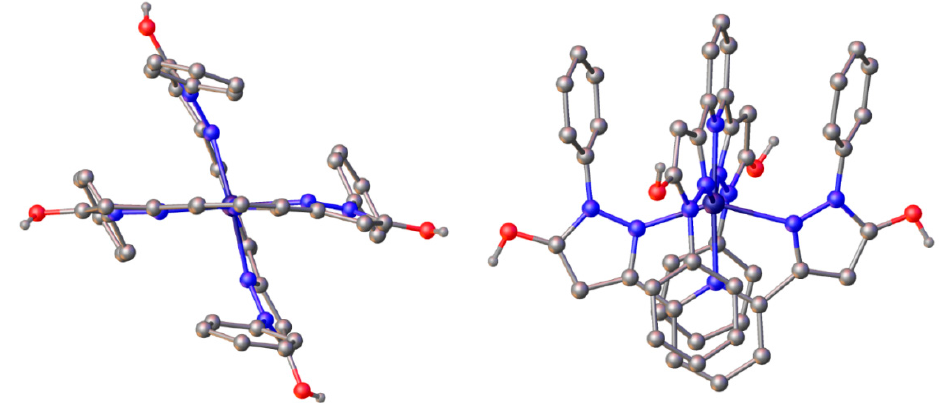
Figure 6. Two projections of the cation [Fe(L) 2 ] 2+ in Fe( L1 ) 2 OTf 2 .